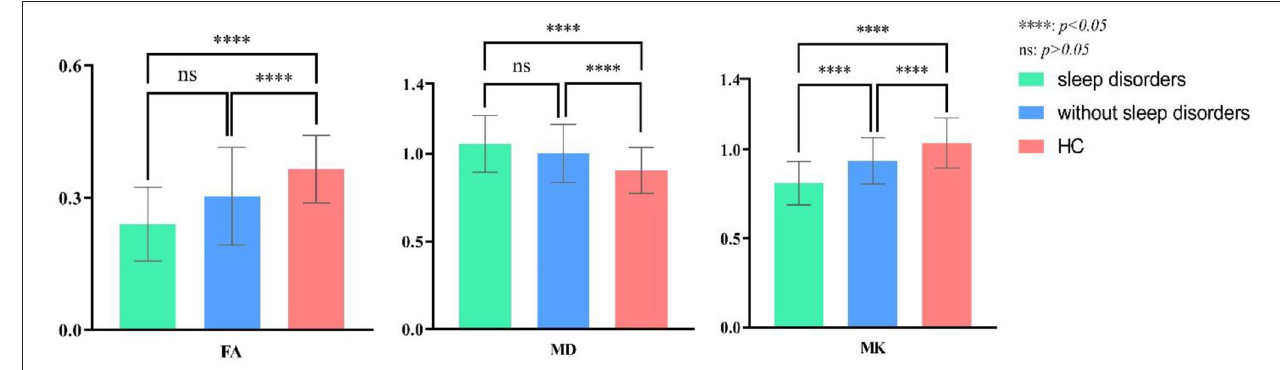
FIGURE 4 | Post-hoc multiple comparison in DKI parameters of L-TLE with or without sleep disorders and the healthy controls.